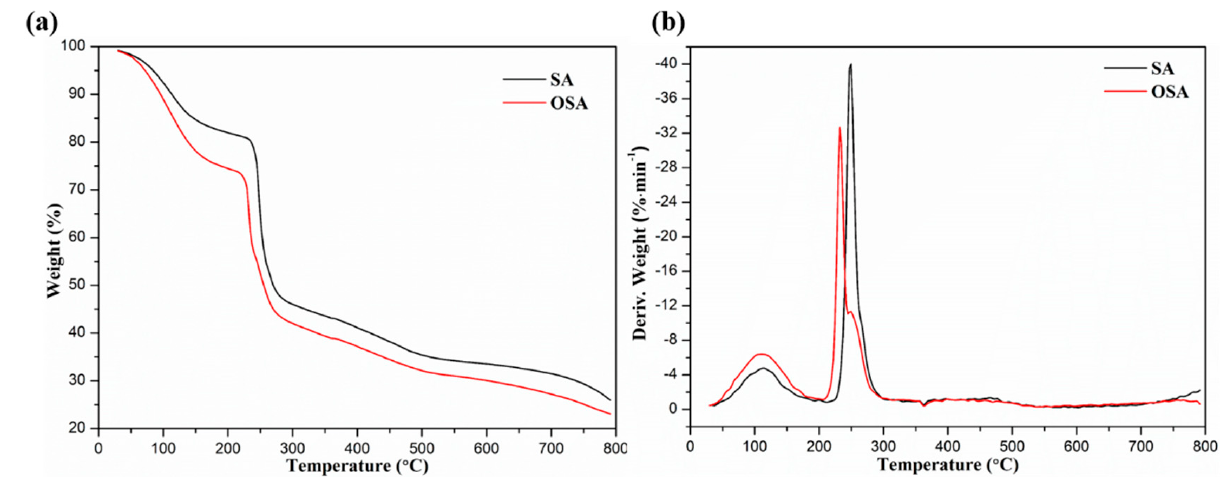
Figure 7. ( a ) TGA curves and ( b ) DTG curves of SA and OSA.